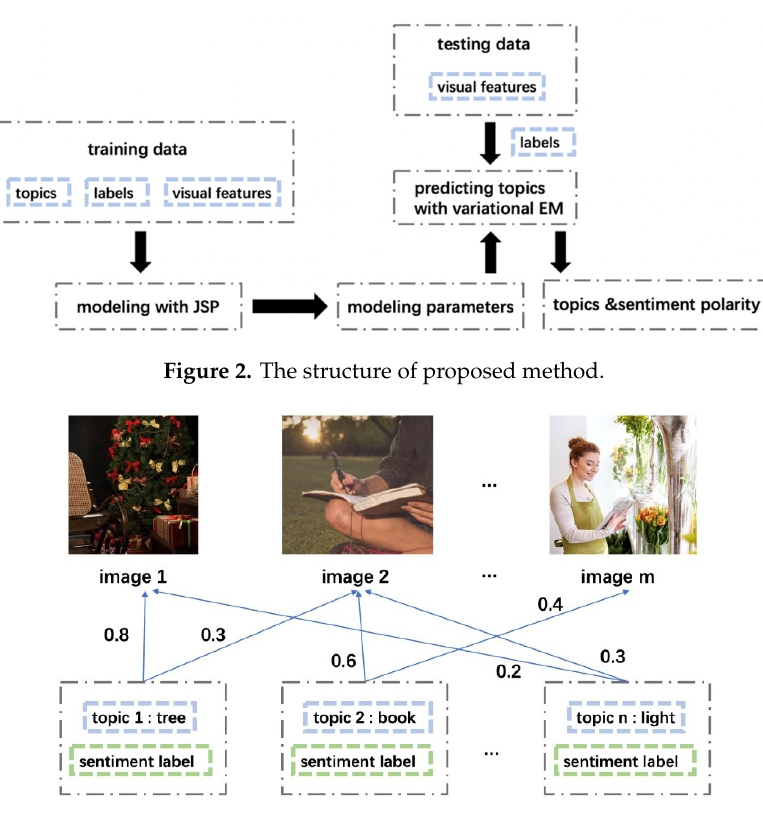
Figure 3. The example of predicted values assigned.